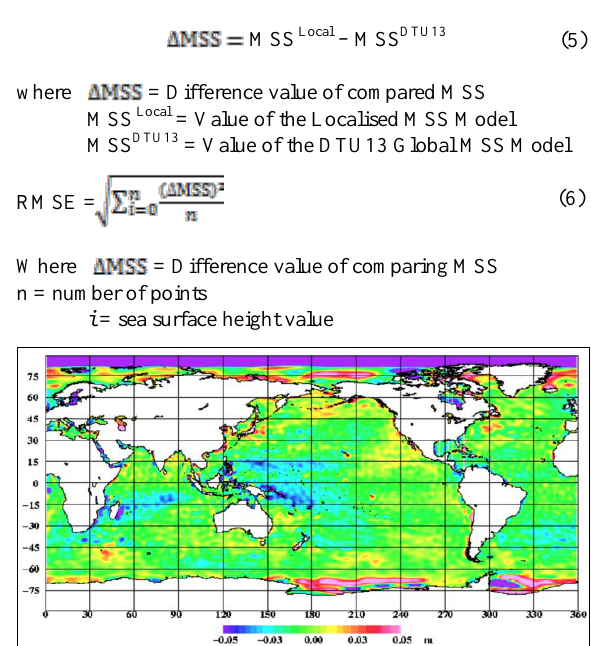
Figure 3. DTU13 Global Mean Sea Surface Model (Anderson et al